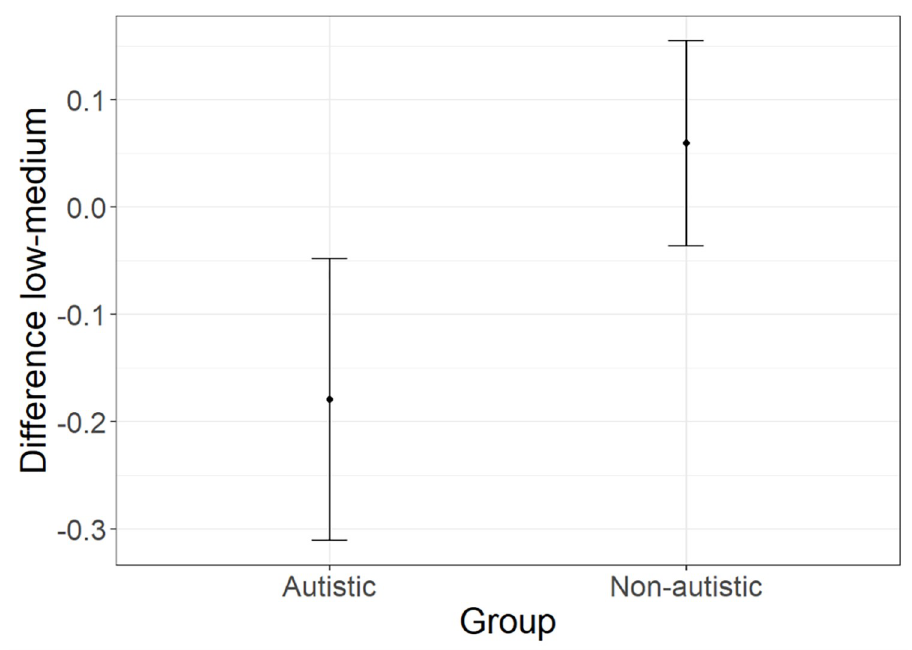
Fig 2. Group effect predicted by m1. Relative choice of the response with medium—vs. low—probability of delivering a neutral vs. no effect, with whiskers representing 95% confidence intervals.